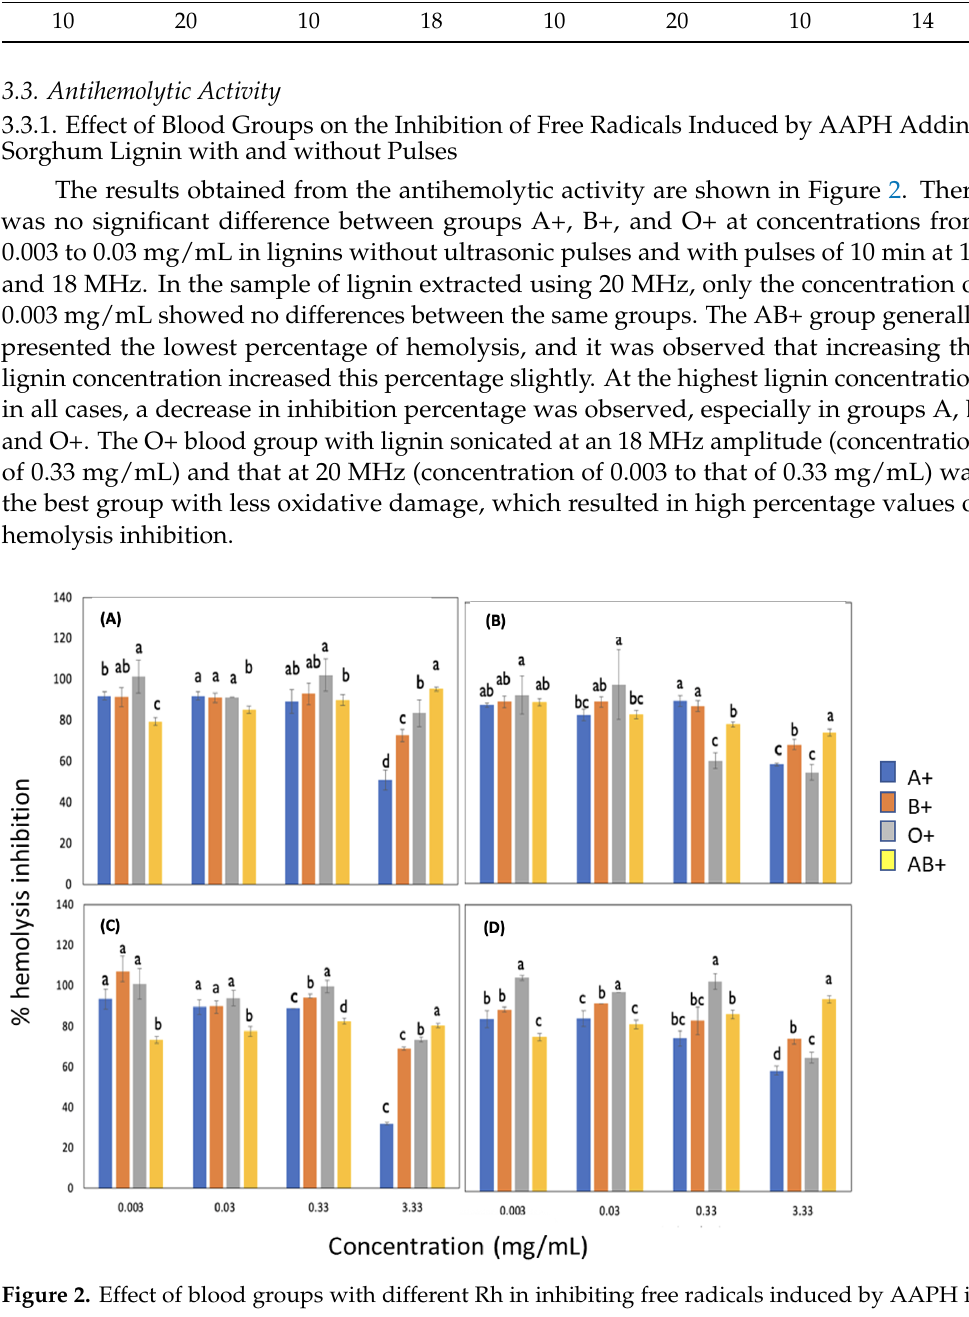
nin can act by inhibiting erythrocyte lysis; one is that lignin protects the erythrocyte from free radicals in the cell membrane. Another possible mechanism is that it stabilizes the free radicals generated by AAPH before they reach the erythrocyte. 3.3.2. Effect of Rh on the Inhibition of Free Radicals Induced by AAPH with Lignin with and without Pulses Figure 3 shows the effect of Rh on the inhibition of free radicals. The results indicated that the degree of inhibition depends on the lignin concentration, both with ultrasonic pulses and without pulses. In general, Rh-negative groups were more susceptible to he- molysis, mainly in group O. However, it can also be observed that, depending on the lig- nin concentration, in some cases, the Rh- groups presented higher hemolysis percentage values than the Rh-positive ones. A possible mechanism for that would be that lignin shows some affinity for the protein found in erythrocytes interacting with it; therefore, in that way, hemolysis might be prevented more in the Rh+ groups than in the Rh- ones.